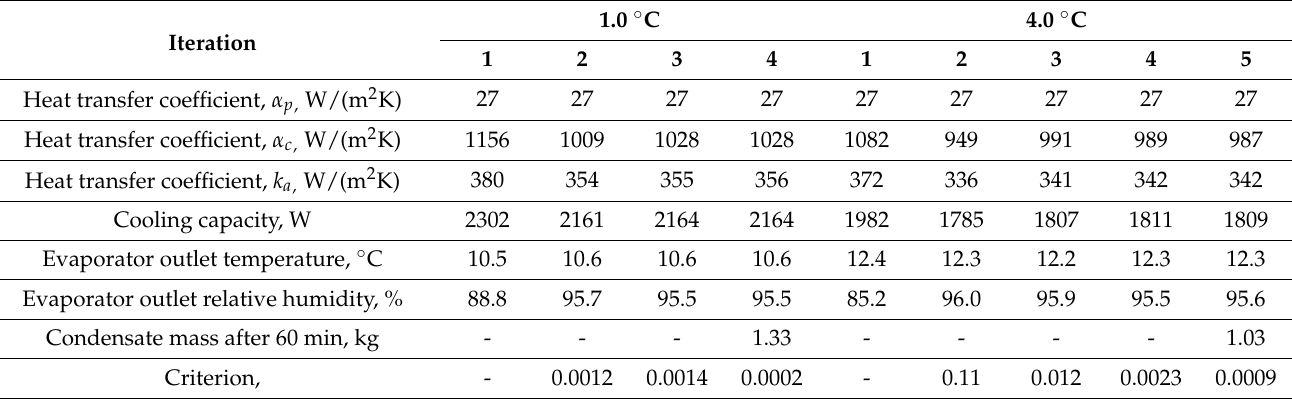
Table 3. Results of iterations of heat exchanger calculations: for an evaporation temperature of 1.0 ◦ C, for an evaporation temperature of 4.0 ◦